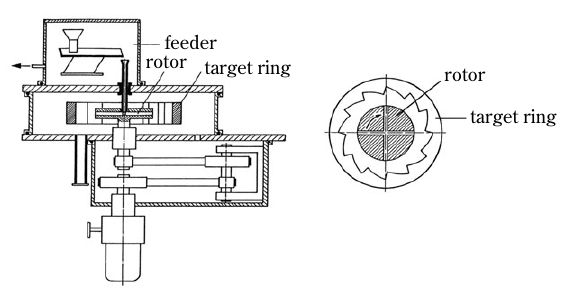
Fig. 1 Single particle impact device